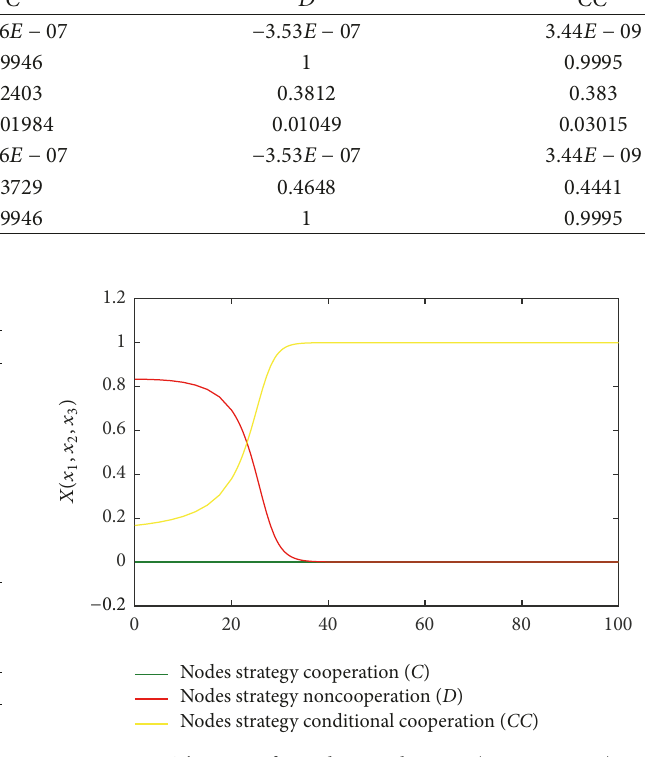
Figure 13: The state of population when 𝑥 = (0, 0.833, 0.166).